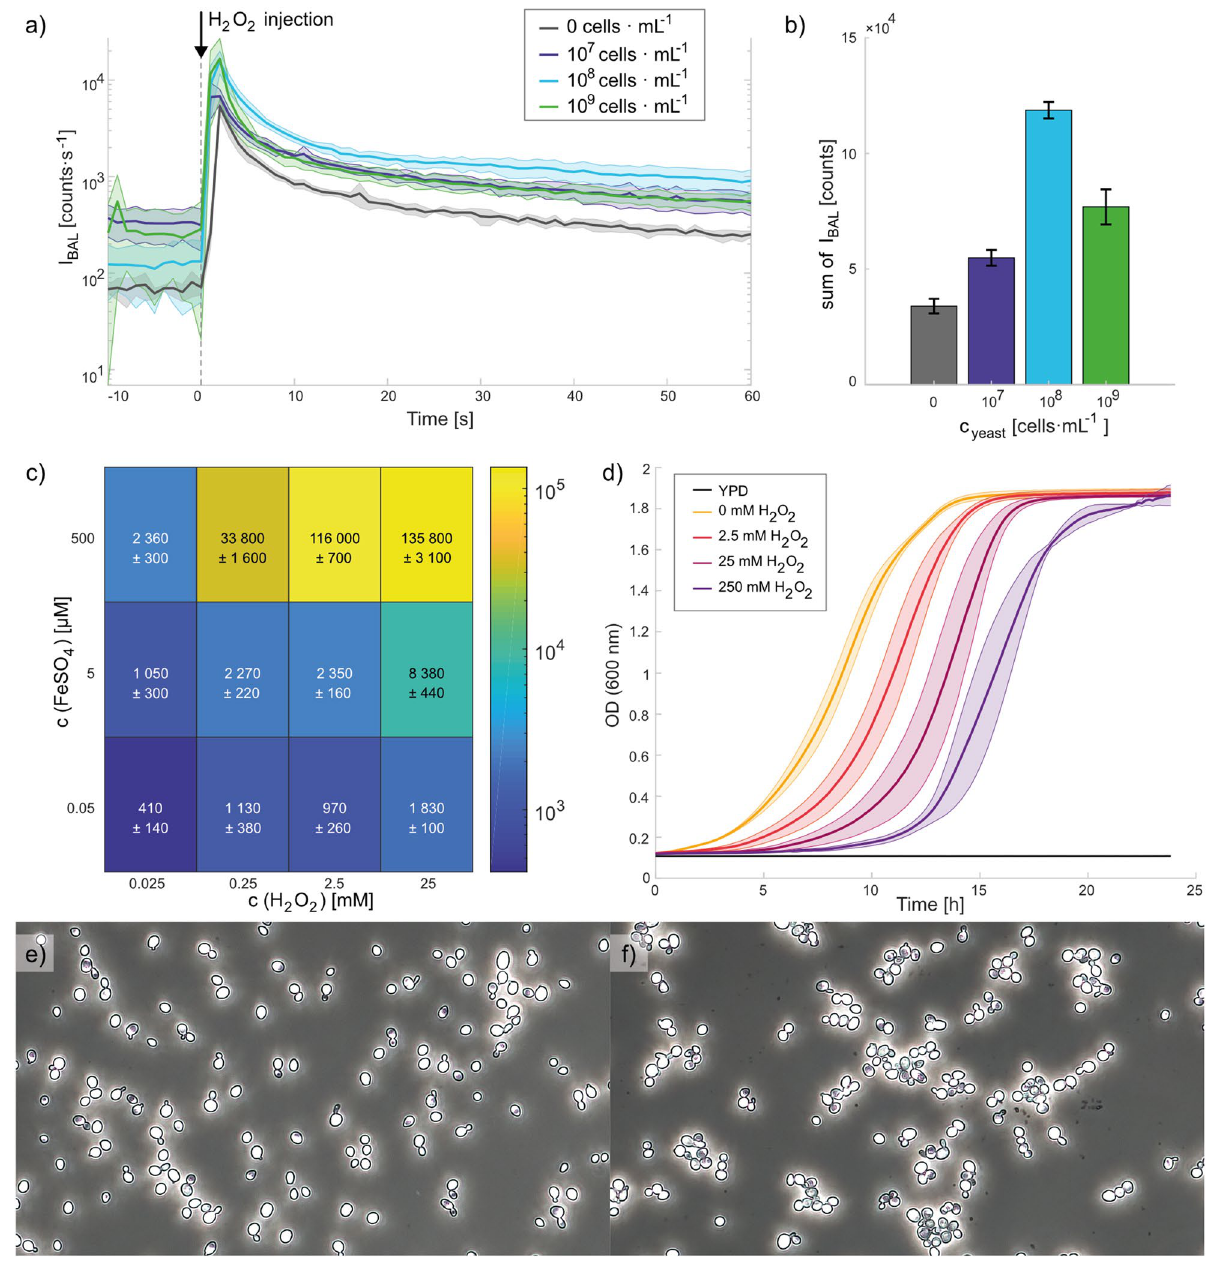
Figure 3. Effects of the Fenton reaction on BAL of yeast, their growth curve, and evaluation of the oxidised yeast under a microscope. First two graphs ( a,b ) show induced BAL of yeast by the Fenton reaction (0.5 mM FeSO 4 , 2.5 mM H 2 O 2 ) for different concentrations of yeast ( 10 7 – 10 9 cells mL − 1 ). Part c) displays induced yeast BAL by the Fenton reaction for various concentrations of Fenton reagents (50 nM–0.5 mM FeSO 4 , 25 µ M – 25mMH 2 O 2 ) and a fixed yeast concentration ( 10 8 cells mL − 1 ). ( a ) BAL kinetics after the injection of hydrogen peroxide into the sample after 10 seconds of background measurement (t = 0). ( b ) Bar graph and ( c ) heat map of the sum of the BAL intensities during the first 60 s after injection of H 2 O 2 with a subtracted background (the previous 10 s before the injection of H 2 O 2 ). ( d ) Yeast growth curves after oxidation of cells ( 10 8 cells mL − 1 ) by the Fenton reaction ( ∼ 10 min; 0.5 mM FeSO 4 , 0/2.5/25/250 mM H 2 O 2 ) depicted by OD at 600 nm. In all cases ( a – d ), the average from 3 measurements and the standard deviation are shown. Microscopic pictures of a yeast sample in water ( e ) before and ( f ) after the Fenton reaction ( ∼ 10 min; 0.5 mM FeSO 4 , 2.5 mM H 2 O 2 ). Yeast concentrations (3–9 µ m in a diameter) were 10 8 cells mL − 1 before and 3 · 10 7 cells mL − 1 after